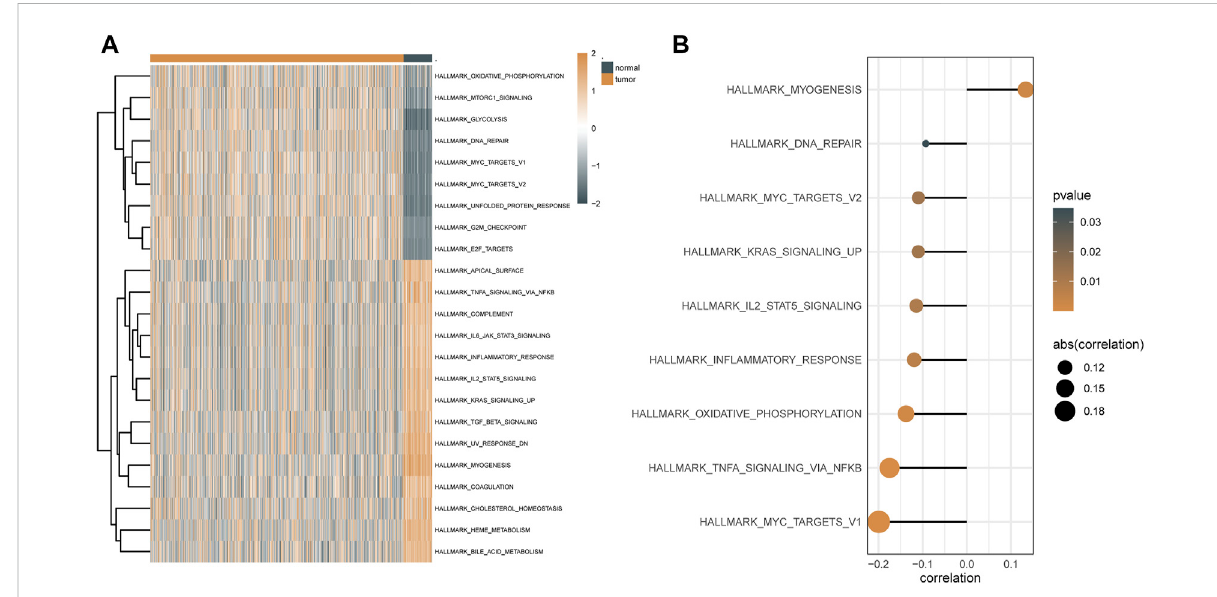
FIGURE 6 GSVA results based on hallmark gene sets. (A) Heat map of differential pathways of GSVA analysis depended mainly on hallmark gene sets. (B) Correlation analysis between differential pathways and ATP6AP1